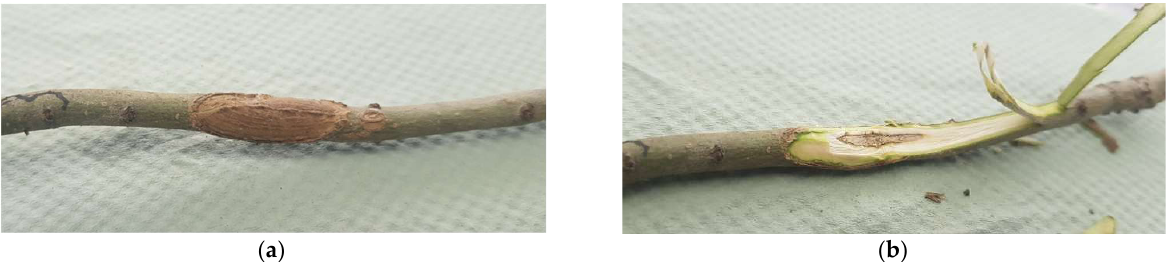
( b ) Figure 5. Inoculated saplings showing no symptoms of the disease shown in side view ( a ) and view from above ( b ). Saplings were watered by BTHWA prior to and post inoculation (W1 variant). The arrow indicates the place of inoculation. 4. Discussion Trees, as long-living organisms, can evolve resistance mechanisms that allow them to defend against pathogens [9]. Nielsen et al. have indicated that ash through the genetic resistance of individuals seems to reduce the susceptibility to ADB [10]. Analyses indi- cate that most of the total European ash population presents some level of resistance against HF [31]. Other studies have indicated also that soil may indirectly affect ADB by the promotion of fungus inoculation because of high soil moisture and soil reaction var- iability [4,6,32]. Among the soil factors affecting the mortality rates of ash are soil pH, calcium carbonate content, high air humidity, and shallow groundwater table level [5,33]. These soil conditions occur in alder-ash forest chosen to collect ash saplings for our ex- periment. Thus, a recent study revealed a high ash saplings mortality within the studied forest compartment [7]. However, the results of our experiment indicate that HF presence in ash individuals can be slowed down or even stopped. Currently, there are no effective methods to protect ash trees. Different physical and chemical methods of treatment have been used to restrict the production and spread of ascospores, including the removal of plant debris from infected sites, preventing move- ment of infected ash saplings to new sites, or using fungicides and biocides [32,34,35]. A recent study has shown that the application of phosphites could improve the health of treated saplings after artificial inoculation with HF [29]. The same study indicated the importance of interactions between H. fraxineus and Phytophthora spp. inoculation. It turned out that when soil inoculation with Phytophthora was performed 2 weeks before H. fraxineus shoot inoculation, more than 40% of the seedlings survived. In the variant of inoculation with H. fraxineus only, the mortality rate was 100% [29]. This implies that in